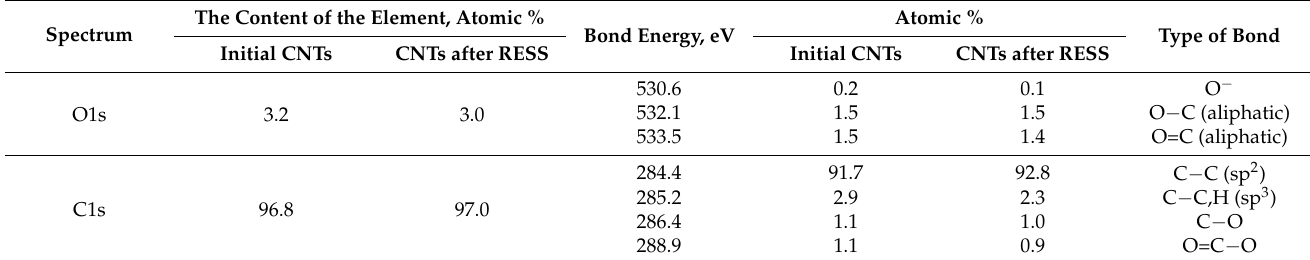
Table 2. Mechanical properties of PC-cylindrical carboxylated CNT composites obtained by different methods. Exp.